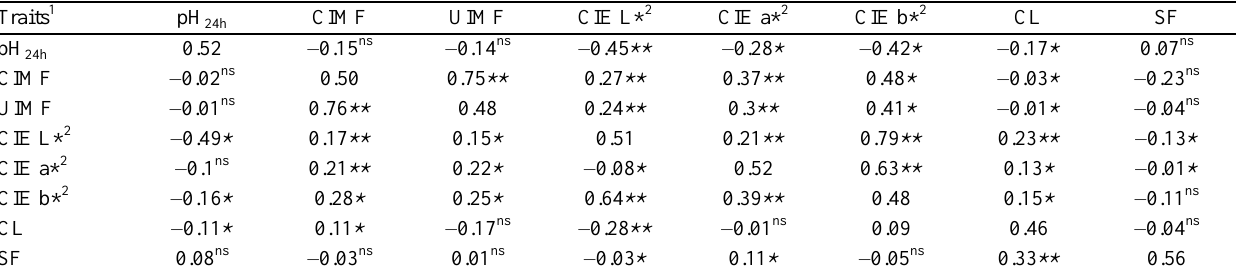
Table 3. Heritabilities (diagonal), genetic correlations (above diagonal) and phenotypic correlations (below diagonal) among meat quality traits and ultrasound intramuscular fat percentage Traits